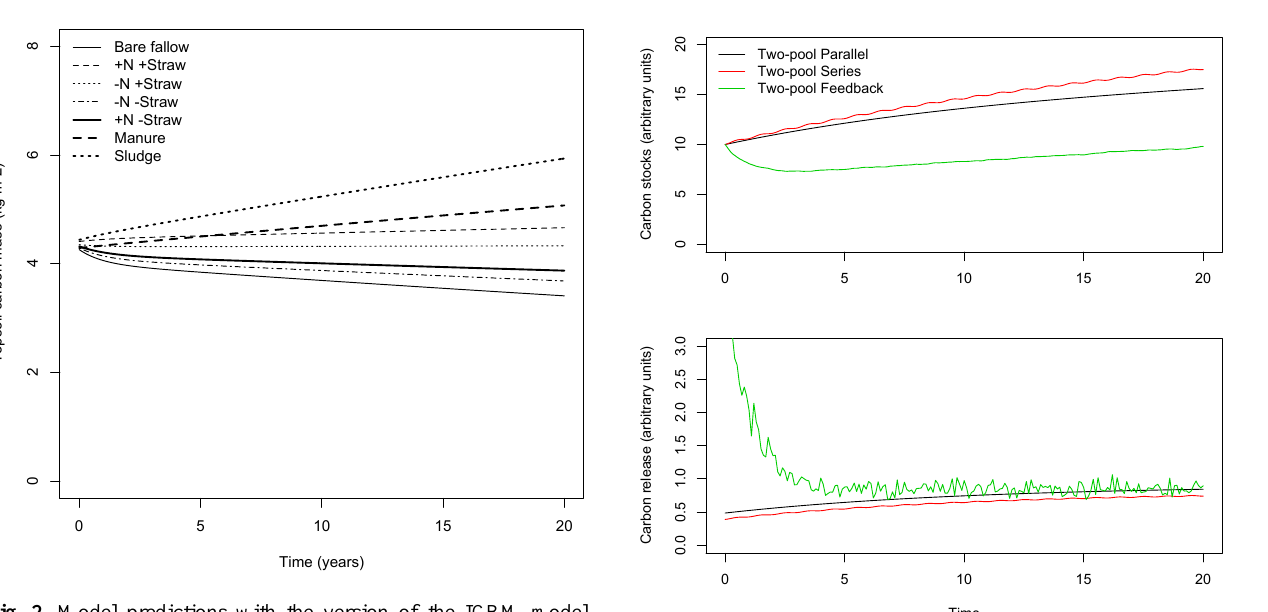
Fig. 2. Model predictions with the version of the ICBM model implemented in S OIL R. This graph reproduces Fig. 2 in An- dren and Katterer (1997). This figure can be reproduced typ- ing example(ICBMModel) or attr(ICBMModel,"ex") in S OIL R.